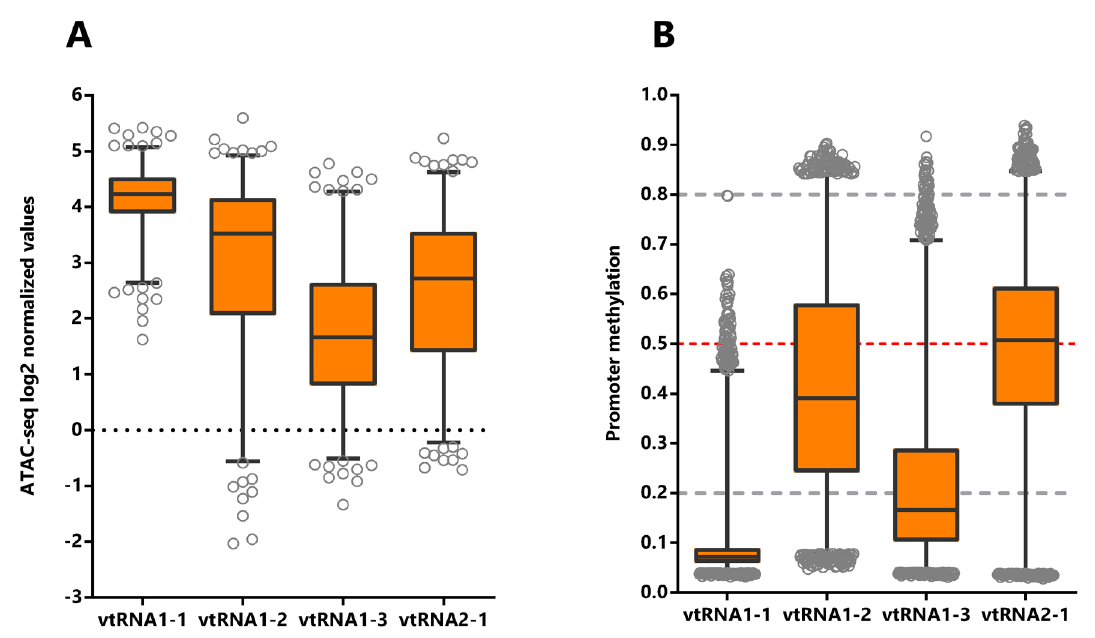
Figure 2. Chromatin accessibility and DNA methylation of the vtRNA promoters. Analysis of vtRNA 500bp promoter region. A. Average chromatin accessibility ATAC-seq values for the 385 primary tumors available at the Pan-Cancer TCGA dataset (23 tissues types). B. Average DNA methylation beta-values for the 8403 primary tumors (32 tissues types). Dashed horizontal lines denote unmethylated (bottom gray, average beta-value ≤ 0.2), 50% methylated (middle red, average beta-value = 0.5) and highly methylated (top gray, average beta-value ≥ 0.8) promoters. The box plots show the median and the lower and upper quartile, and the whiskers the 2.5 and 97.5 percentile of the